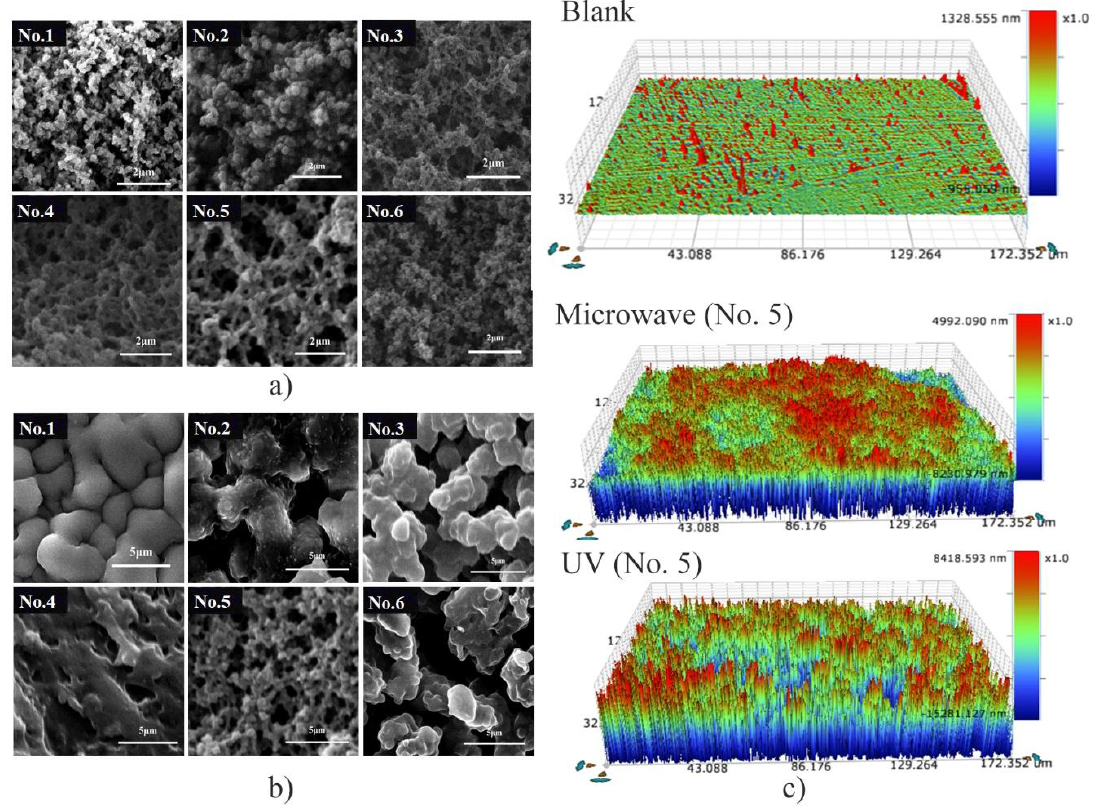
Figure 1. Left: Scanning electron microscopy (SEM) of polymeric coatings fabricated by microwave ( a ) and UV ( b ) irradiation; Right: the comparative roughness of the blank glass slide, the optimal microwave-cured coating, the optimal UV-cured coatings ( c ).